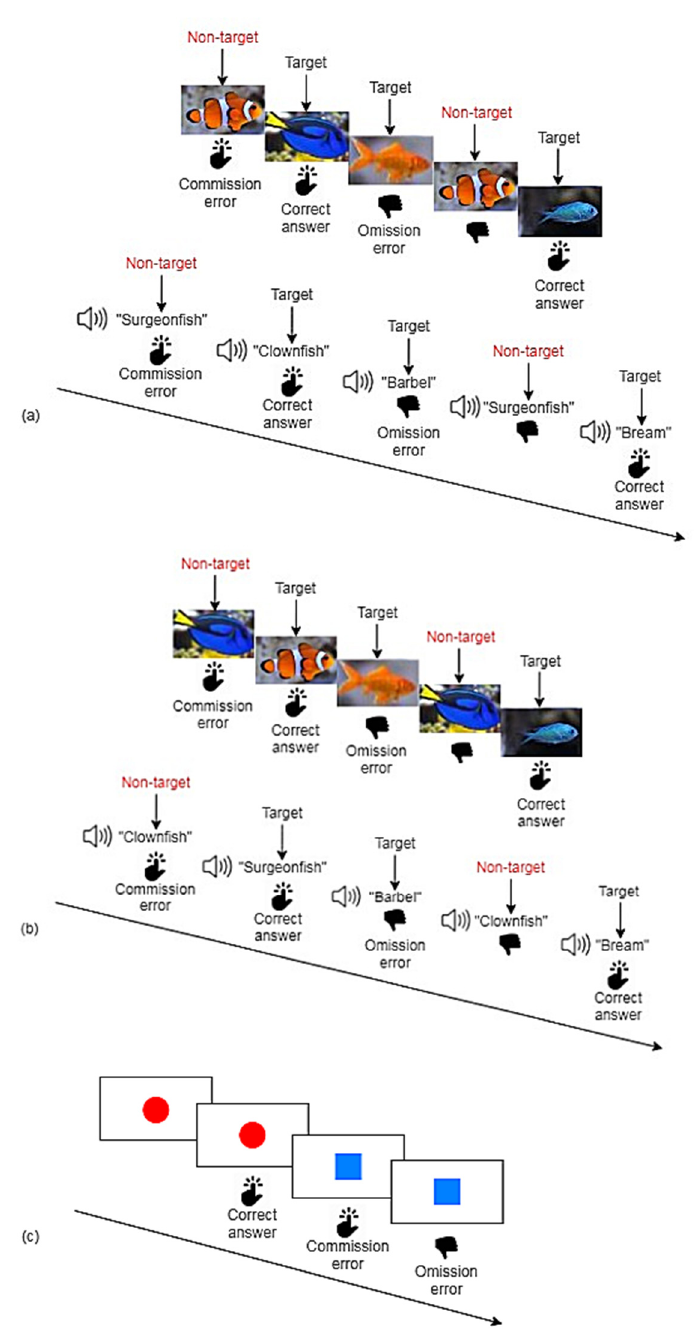
Figure 1. Schematic diagrams of Nesplora Aquarium and Qb-Test. ( a ) In the first step of Nesplora Aquarium, the participant’s task is to press the button in response to all visual stimuli except for clownfish and to all auditory stimuli except for surgeonfish. ( b ) In the second step of Nesplora Aquarium, the participant is asked to press the button while observing all stimuli except for surgeonfish and while hearing all stimuli except for clownfish (inversed task). ( c ) In the Qb-Test, the participant´s task is to press a button whenever an exact repetition of the prior stimulus occurs.